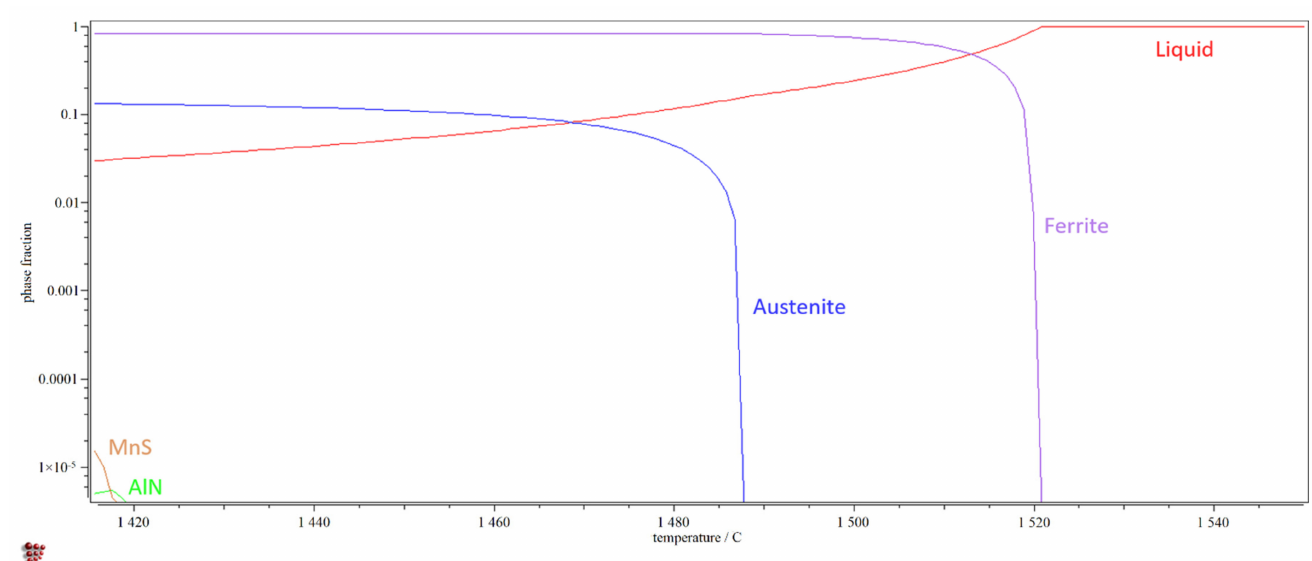
Figure 12. Scheil–Gulliver equilibrium solidification